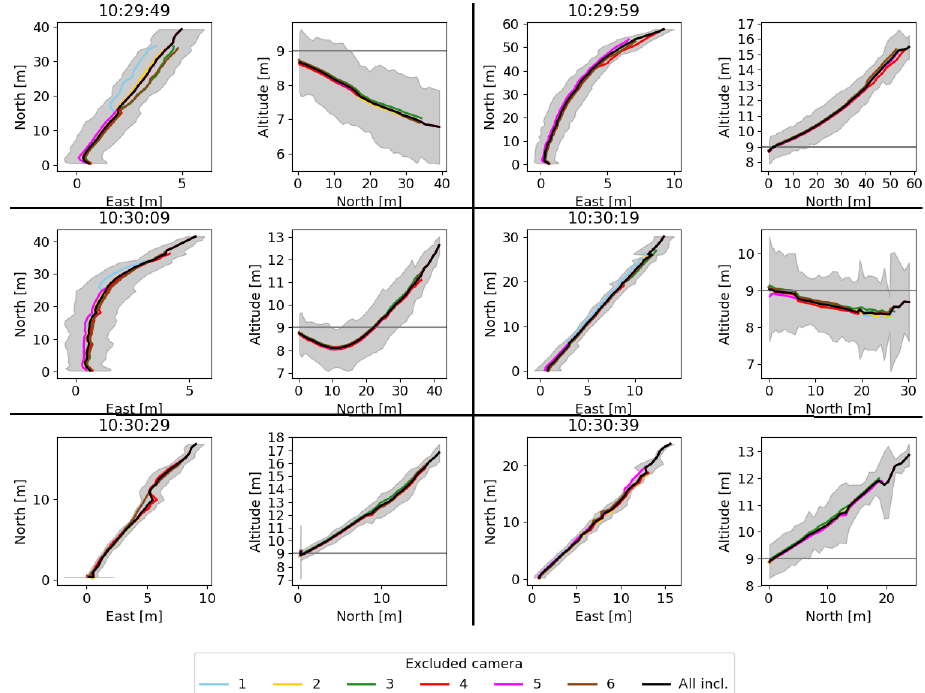
Figure B3. Sensitivity of the reconstructed trajectories to the removal of data from a single camera. The trajectory colour indicates which camera was removed from the calculation, the black trajectory is based on data from all cameras. The time indicates the release time of the puff. In the altitude–north plots, the horizontal line represents the release